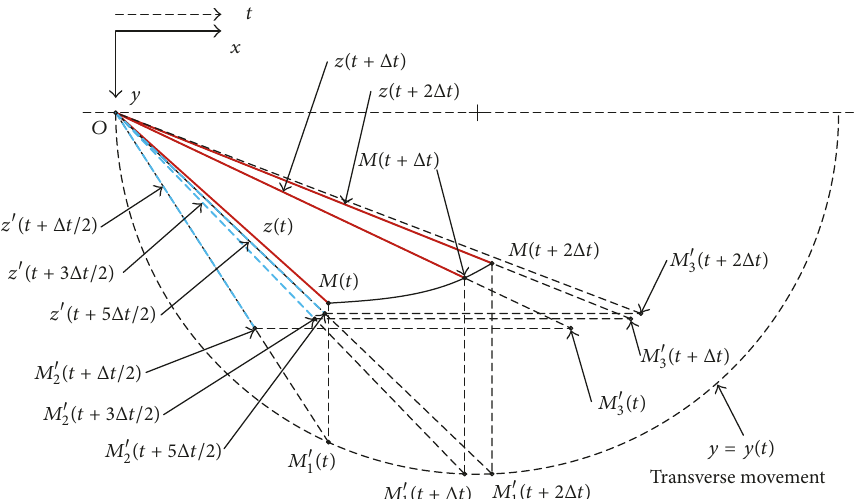
Figure 4: Changes in a general bristles deformation at consecutive phases of sliding and torsional oscillation of the drill